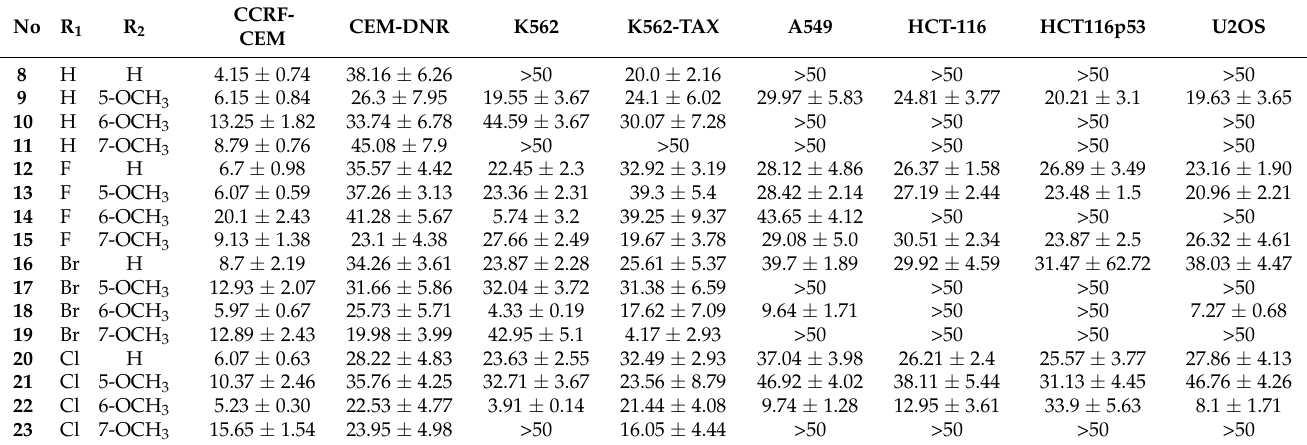
Table 2. Effect of compounds 8 – 23 after 72 h of incubation with cancerous and noncancerous human cell lines and drug resistance